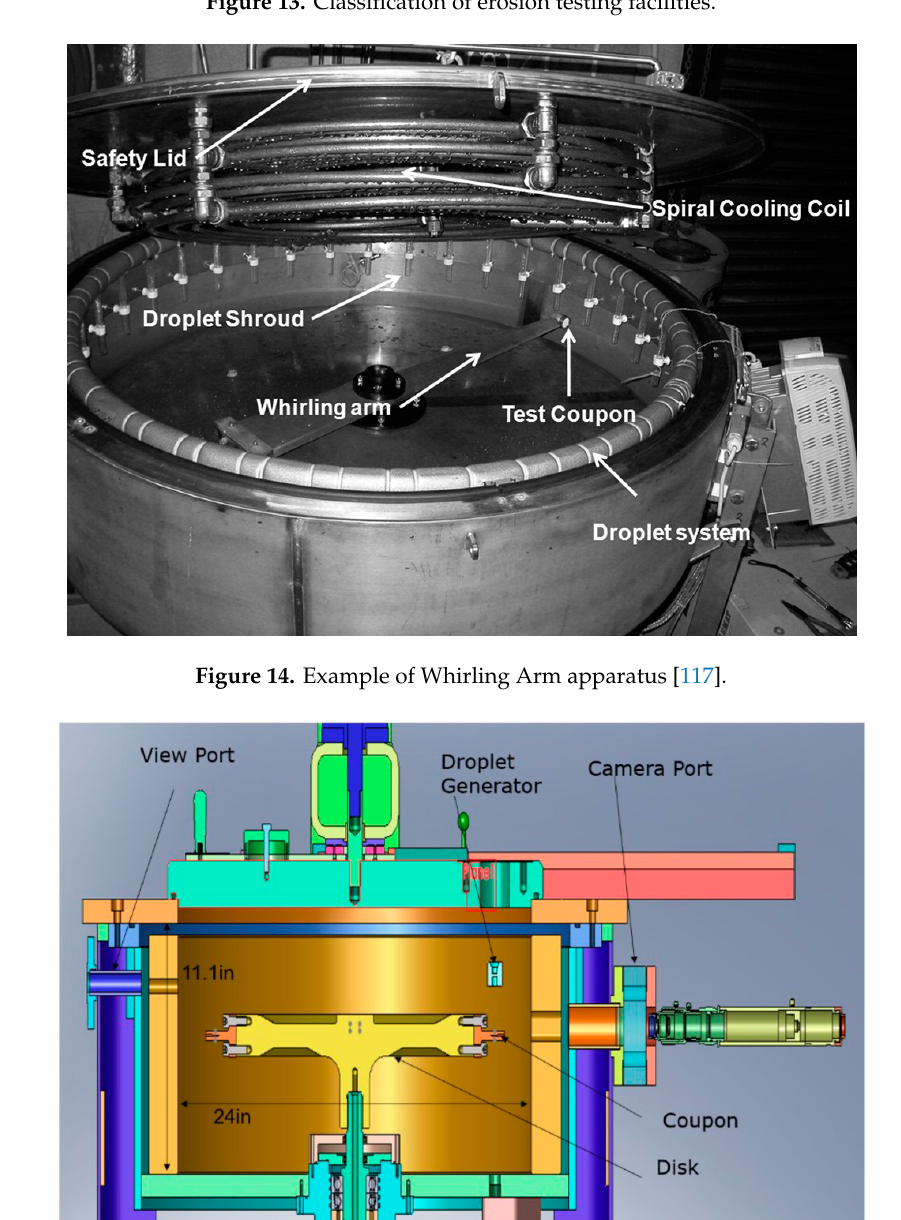
Materials 2019 , 12 , x FOR PEER REVIEW Figure 13. Classification of erosion testing facilities. Figure 13. Classification of erosion testing facilities.